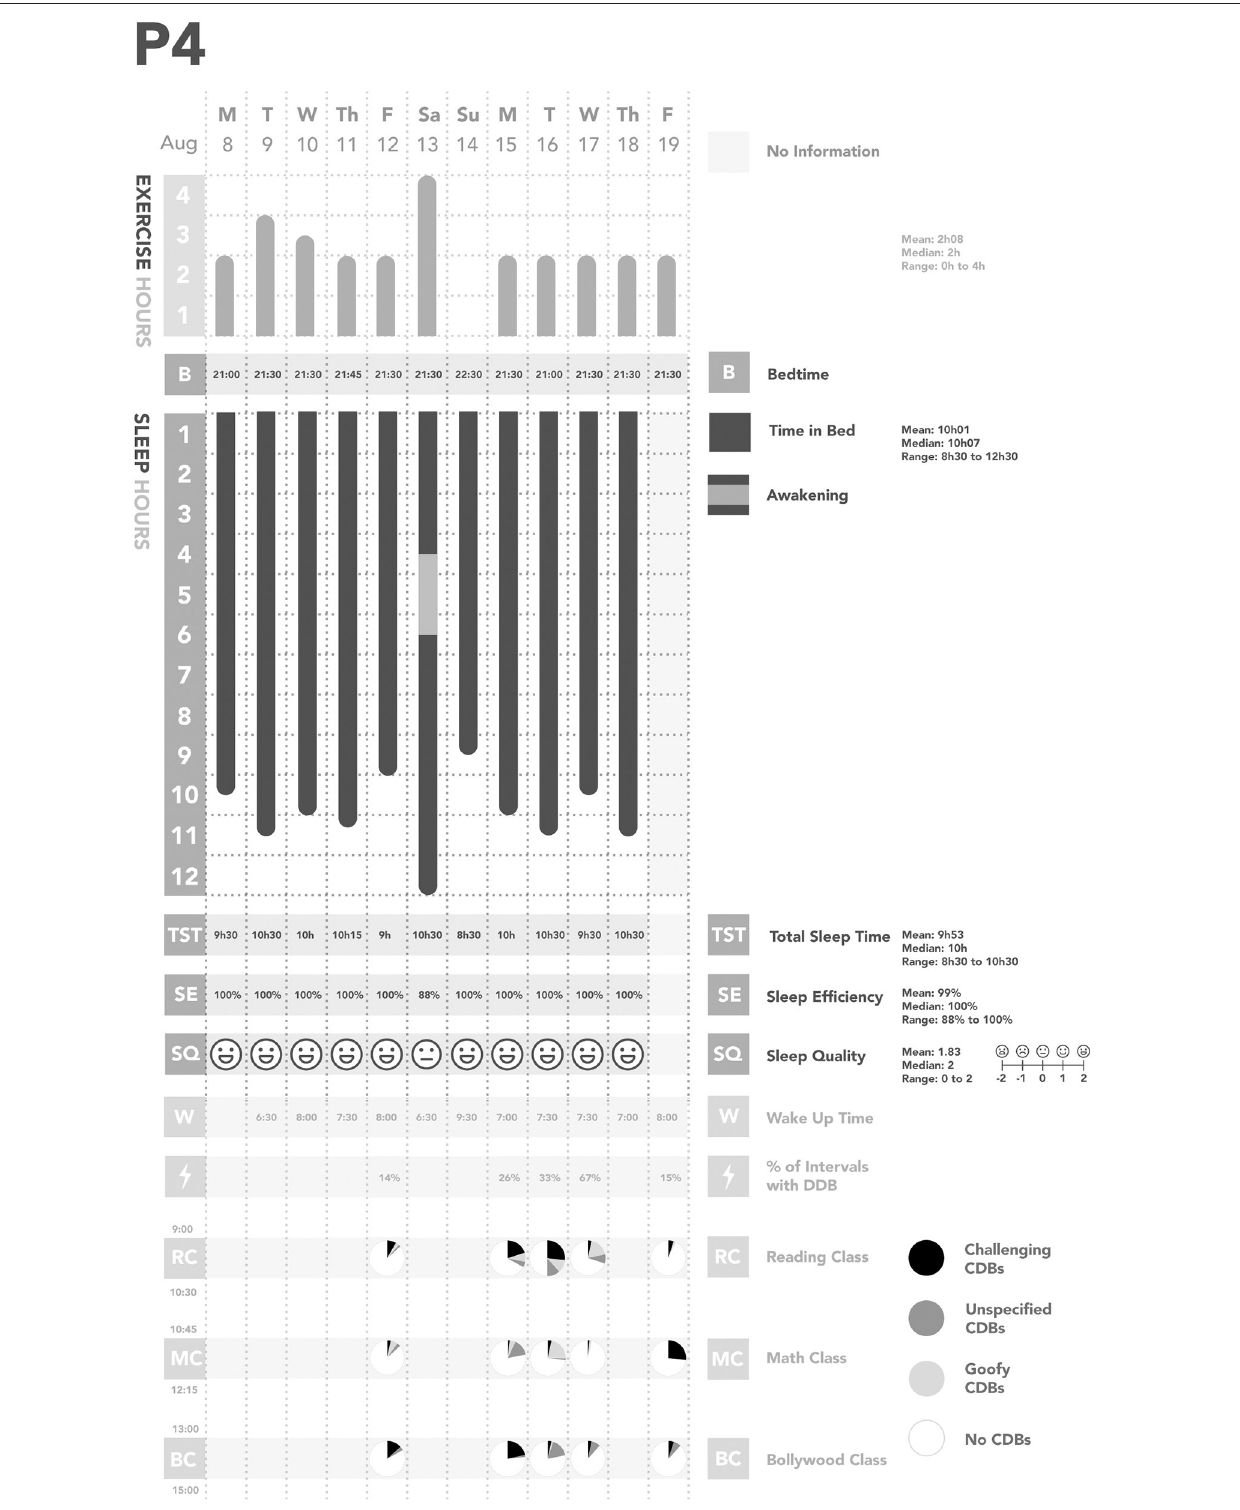
Frontiers in Psychiatry |